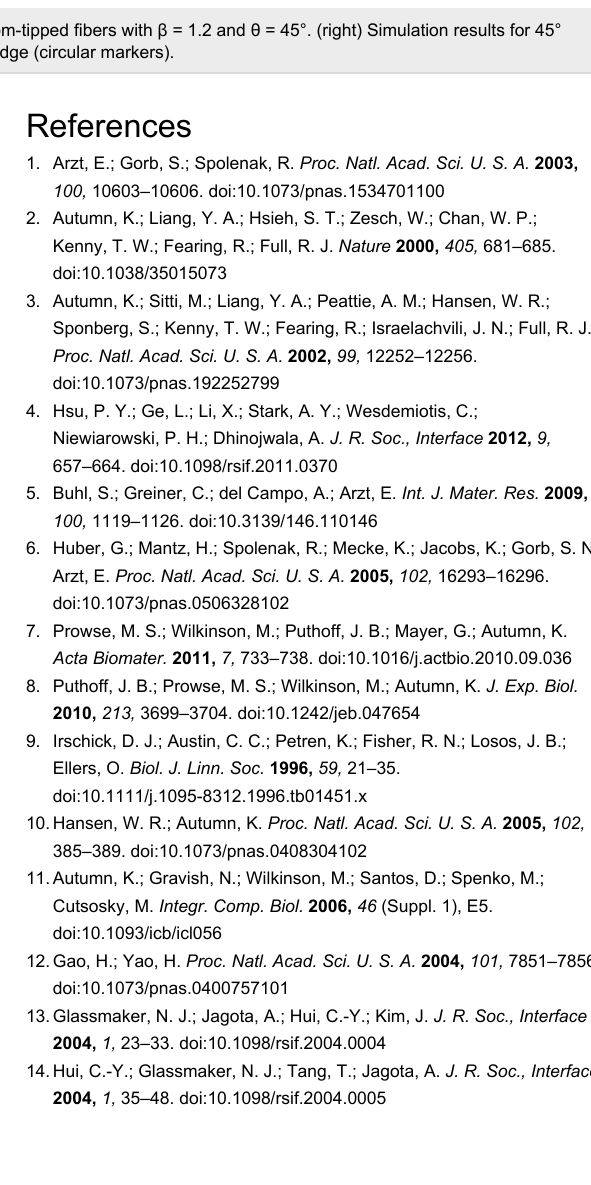
Figure 7: (left) Illustration of three different wedge angles for the mushroom-tipped fibers with β = 1.2 and θ = 45°. (right) Simulation results for 45° wedge (diamond markers), 90° wedge (square markers), and rounded wedge (circular markers).